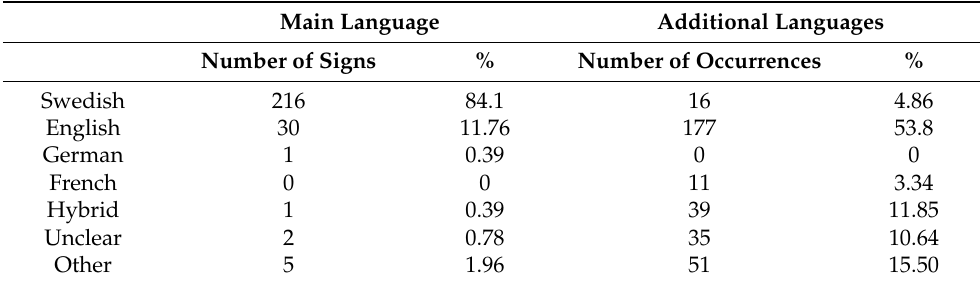
Table 4. Languages on multilingual signs. N = 255 for the main language and N = 329 for additional language as some signs included more than one additional language. Main Language Additional